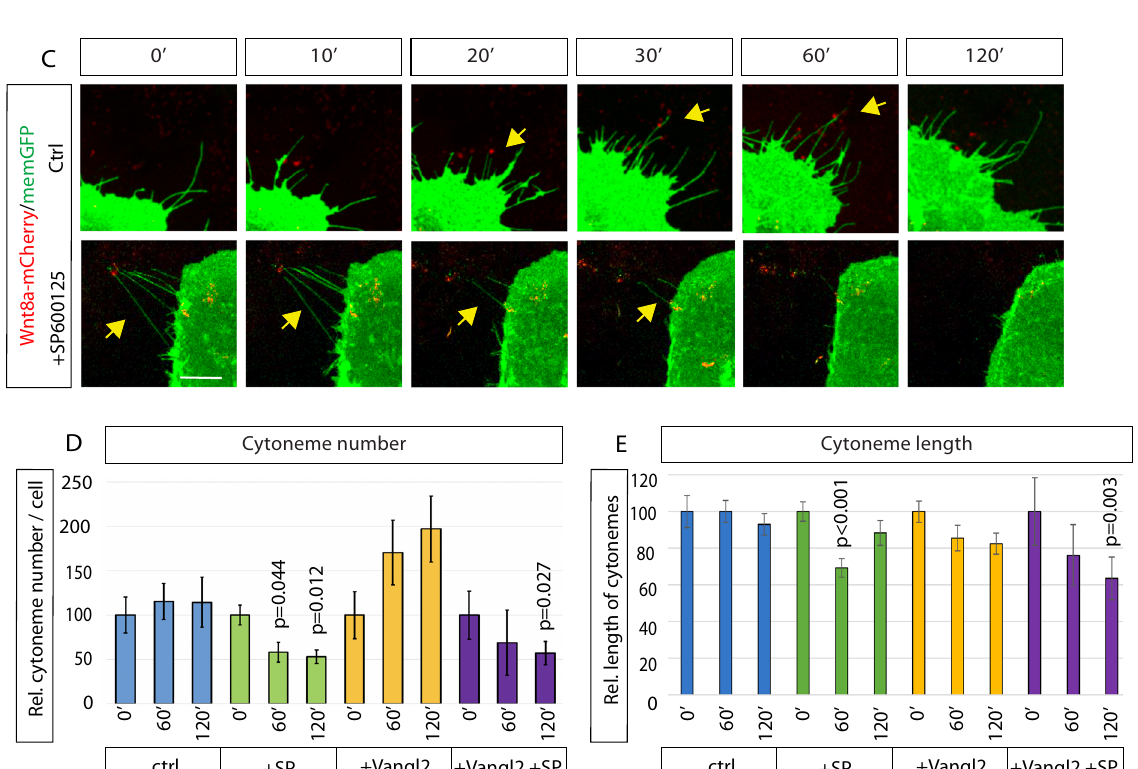
re-arrangement. To do so, we treated cytoneme-bearing cells with Y-27632, an antagonist of Rho-associated kinase (RhoA/ROCK) 41 . While JNK inhibition had a signi fi cant effect at 60 min, Y-27632 treatment produced only a modest and non- signi fi cant reduction of protrusion length after 5 h (Supple- mentary Fig. 6C – G). We conclude that JNK signaling is the primary signaling cascade required for fast cytoneme formation downstream of Wnt/Vangl2/Ror2 signaling and it contributes to the formation of long Vangl2-positive